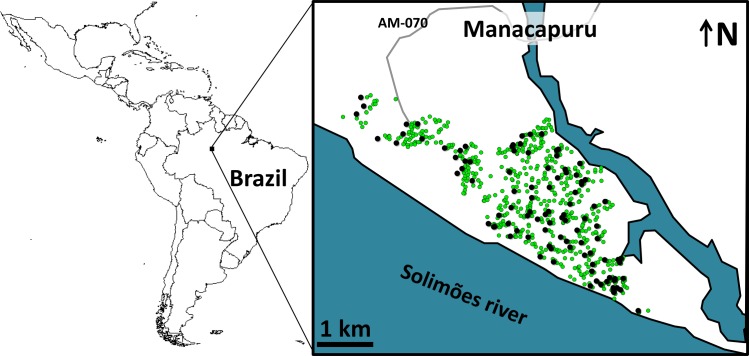
Study site: the city of Manacapuru, state of Amazonas, Brazil.The black circles indicate the location of the 100 dwellings monitored for mosquito vectors; the green circles indicate the location of the 1,000 pyriproxyfen dissemination stations. Circles are overlaid on a schematic of Manacapuru; locations are approximate. The map of Latin America was drawn using the maps library in R 3.1.2 (https://www.r-project.org/).